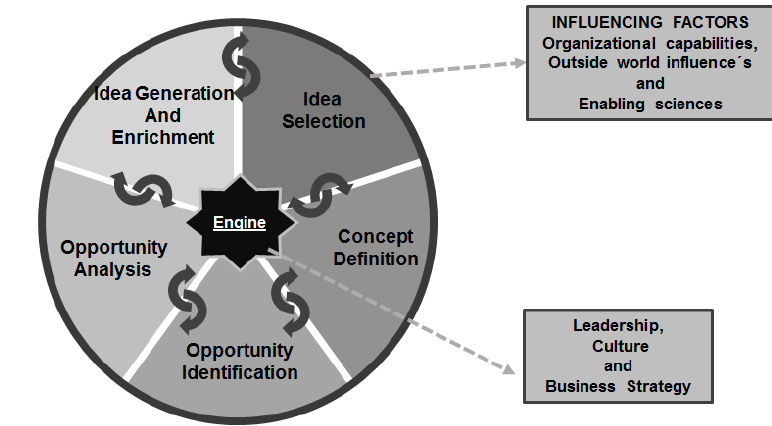
Fig. 2. NCD Model as categories of analysis – Adapted from Koen et al. (2002)